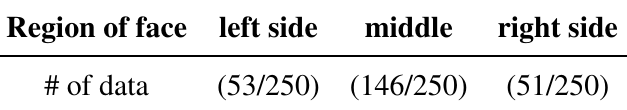
Table 5. The number of profiles according to the regions of face.